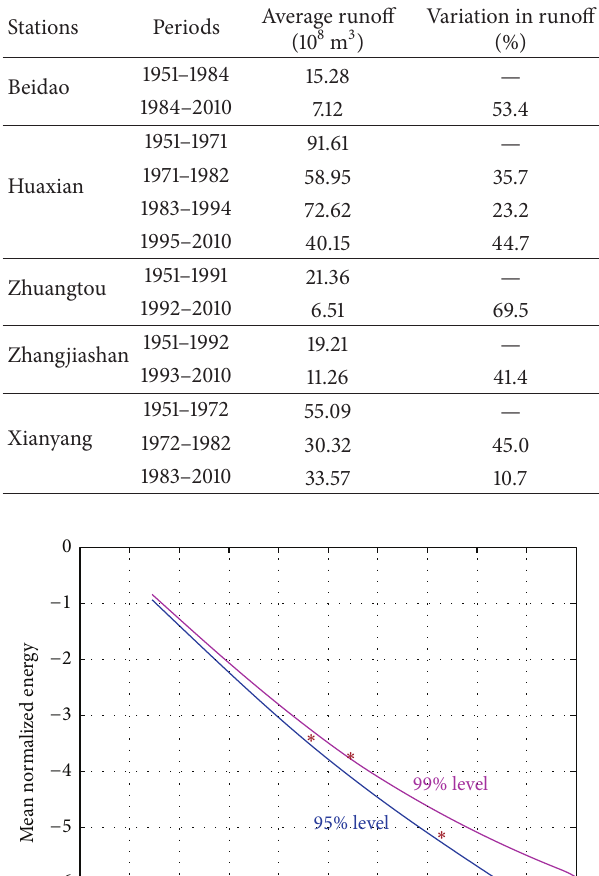
Table 3: The variation amplitudes of average runoff.